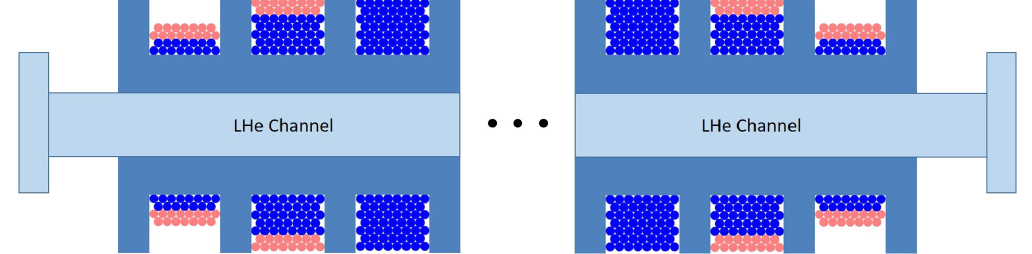
FIG. 4. Winding scheme of the SCU1 magnet. There are 53 conductors in a full main coil pack (blue), 38 main coil conductors in the second to last grooves, and 15 main coil conductors in the end grooves. There are 15 conductors (red) wound over the top of the main coil to form the corrector coil in the last two grooves at either end.